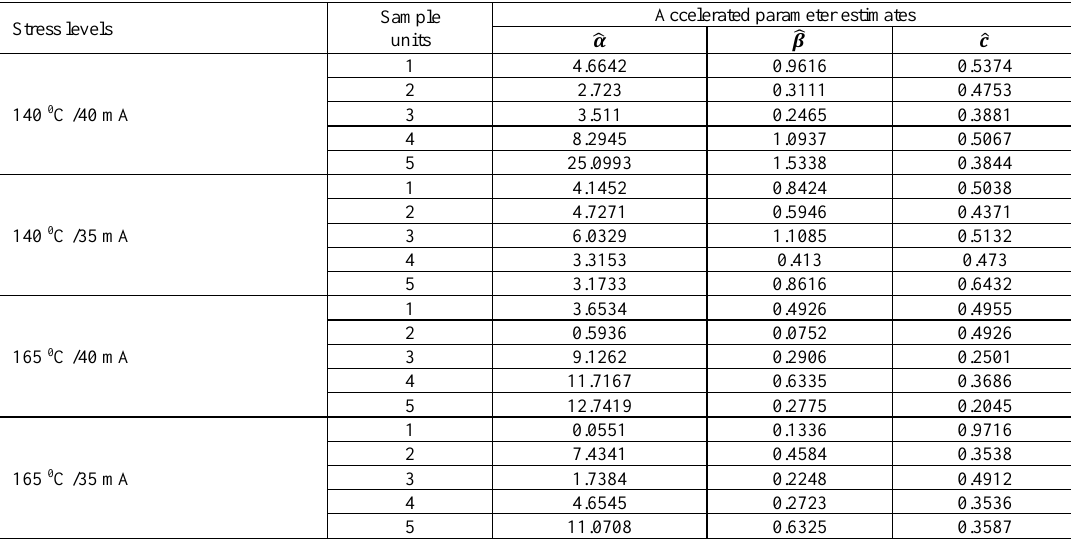
Table 2. Parameter estimates of sample units at different stress levels.